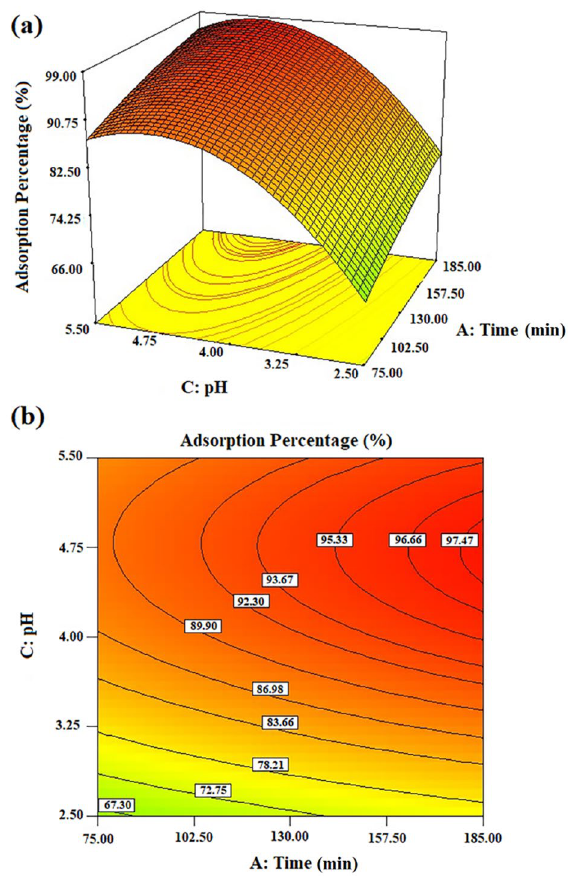
Figure 10. ( a ) 3D plot and ( b ) contour plot showing effect of adsorption time and pH on percentage adsorption of cobalt(II) ions (gram of adsorbent = 0.06 g; Co(II) ions in aqueous solution = 60